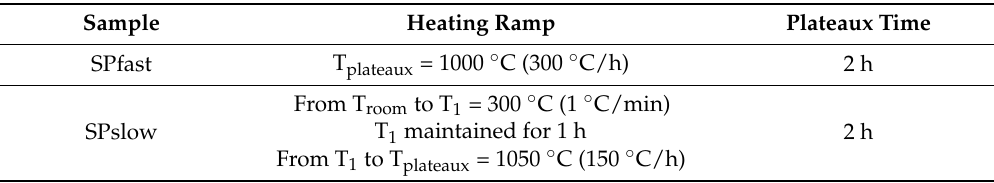
Table 1. Summary table of annealing treatments.